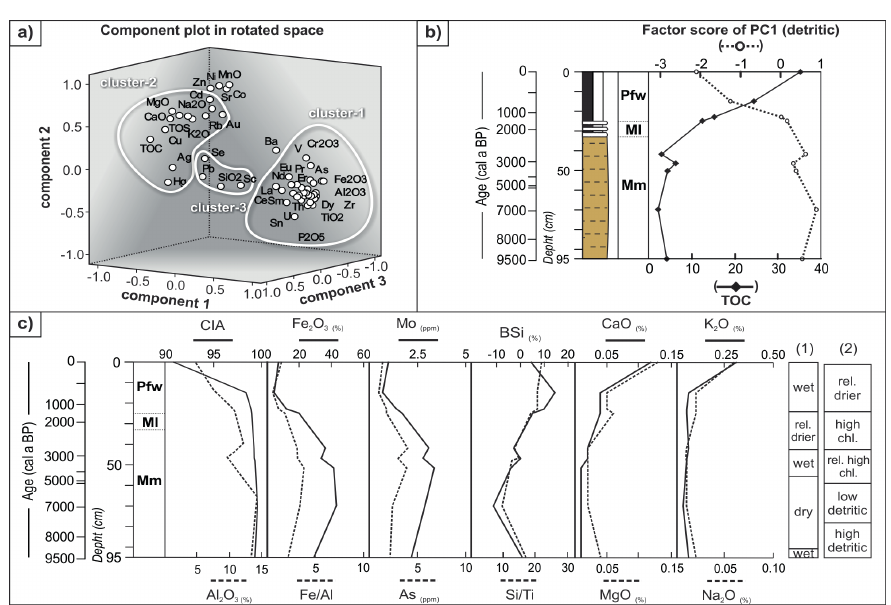
Figure 3 - a) Principal component loading plot of PC1- PC2- PC3 extracted from the Factor Analysis of geochemical components (major and trace elements, and total organic carbon (tOC)) from r4 core; b) factor score of the PC1 and tOC (%) indicates the distribution of detritic and organic components, respectively along the vertical profile; c) Elemental proxies in the r4 core along the depth profile of the R4 core (for stratigraphic discussion see Fig. 2 and Table II). Paleoclimate records of Carajás lakes described for Serra Sul by (1) Sifeddine et al. (2001), and Serra Norte by (2) Cordeiro et al. (2008). rel: relatively, Chl: chlorophyll. Considering this last work, high Chl. is related to increased lake